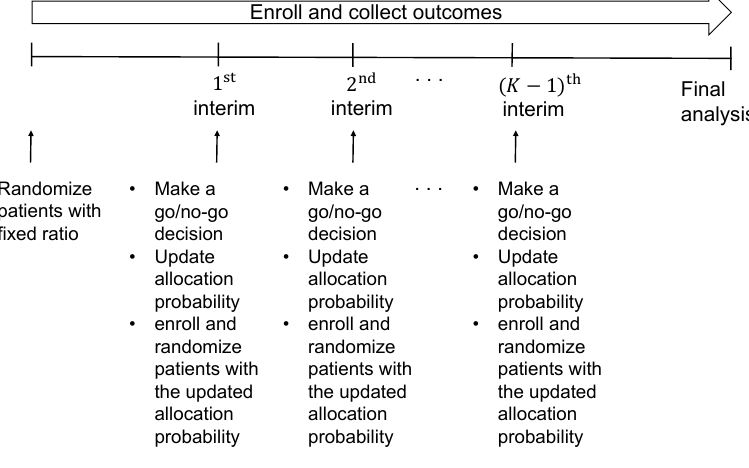
Figure 1. Schema of the proposed